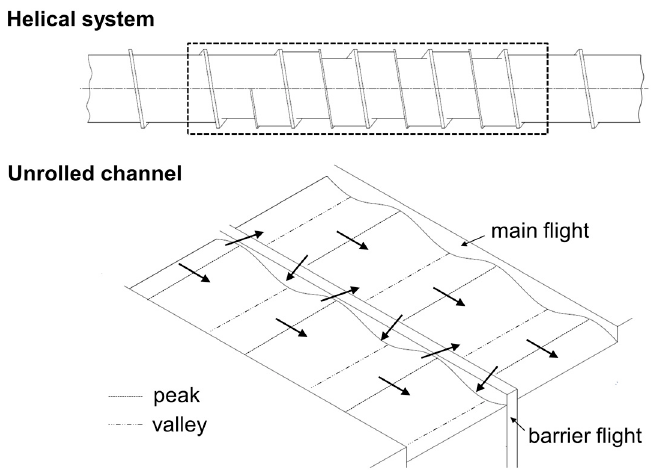
Figure 1. Schematic of a wave-dispersion zone with two flow channels.